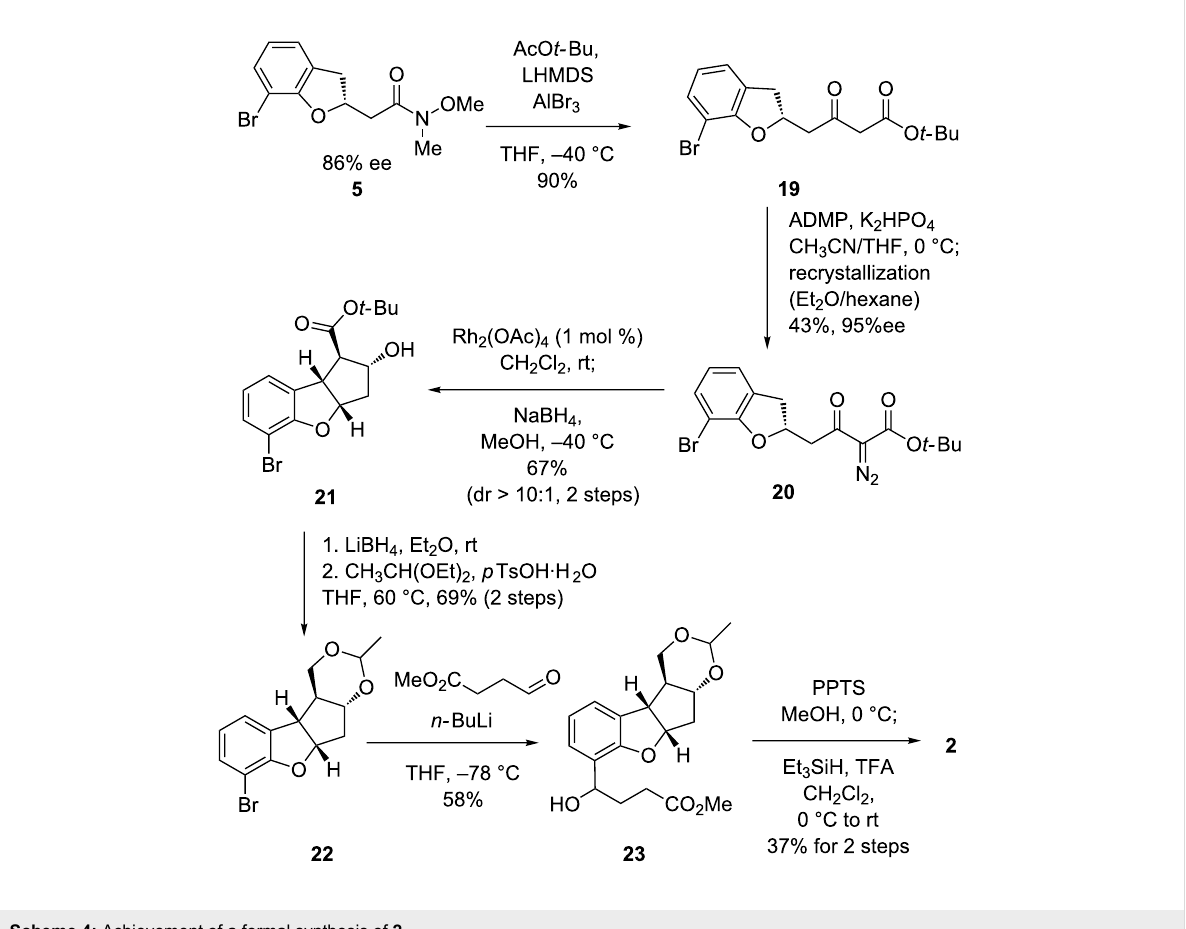
Scheme 4: Achievement of a formal synthesis of 2